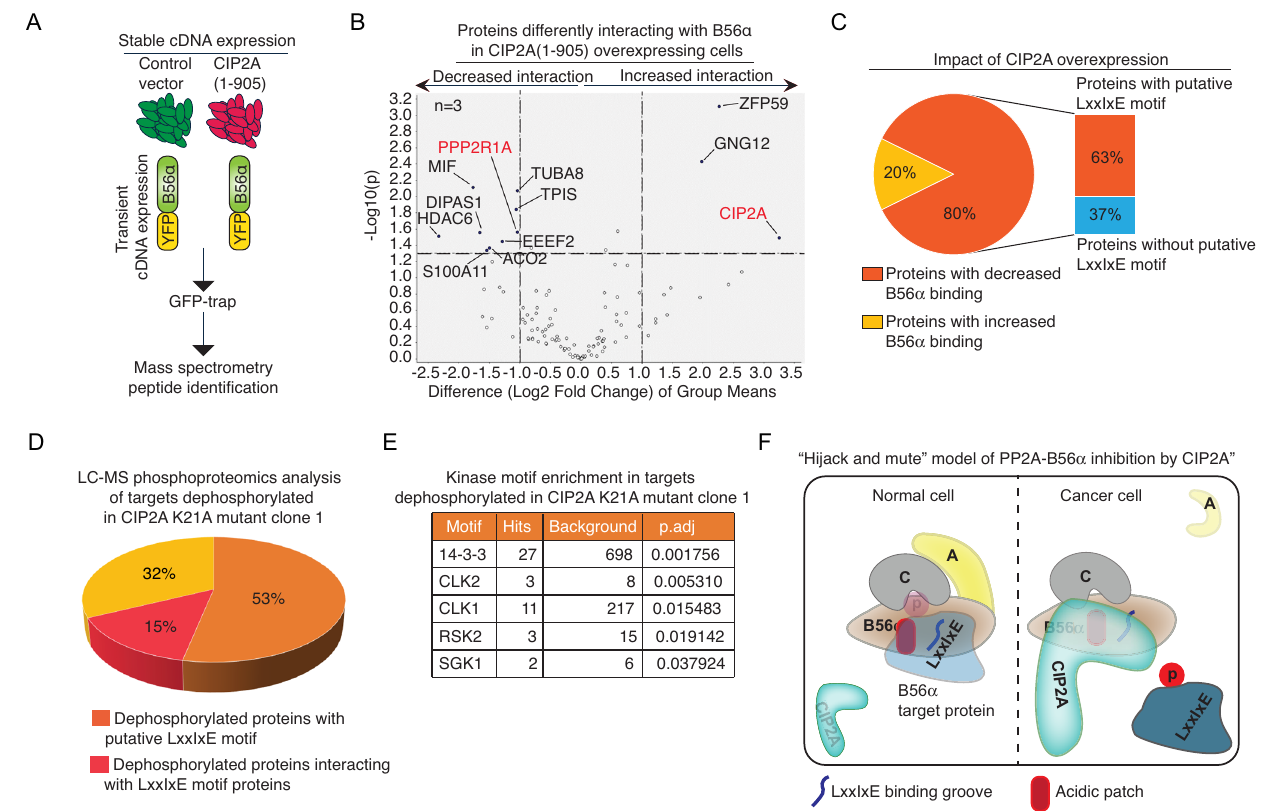
Fig. 6 | Validation of hijack and mute model of B56 α inhibition by CIP2A in cellulo . A NIH3T3cells,stablyexpressing humanCIP2A(1-905)V5, orempty vector control (see Supplementary Fig. 8D), were transiently transfected with YFP-B56 α WT, followed by immunoprecipitation using GFPTrap and analysis by mass spec- trometry. B Proteins differentially interacting with B56 α in CIP2A(1-905)V5 over- expressing cells ( N =3) vs. control ( N =3). Indicated proteins exceed the threshold of 2-fold difference with p <0.05 (two-sided t-test using log2 of protein abun- dances, normalized to the protein abundance of B56 α in the CTRL_1 sample, as an input). C Pie-chart of share of proteins displaying either decreased or increased binding to B56 α upon CIP2A over-expression (excluding PPP2R1A and CIP2A). Bar graphindicates percentualshare ofproteins with putative LxxIxE motifamong the proteins which interaction with B56 α was decreased by CIP2A. D Pie-chart pre- sentation of percentual share of proteins dephosphorylated (FDR<0.05) in CIP2A K21Aclone1ascomparedtocontrolcloneinrelationtoputativeLxxIxEmotiffound from the dephosphorylated protein (in orange), or whether dephosphorylated